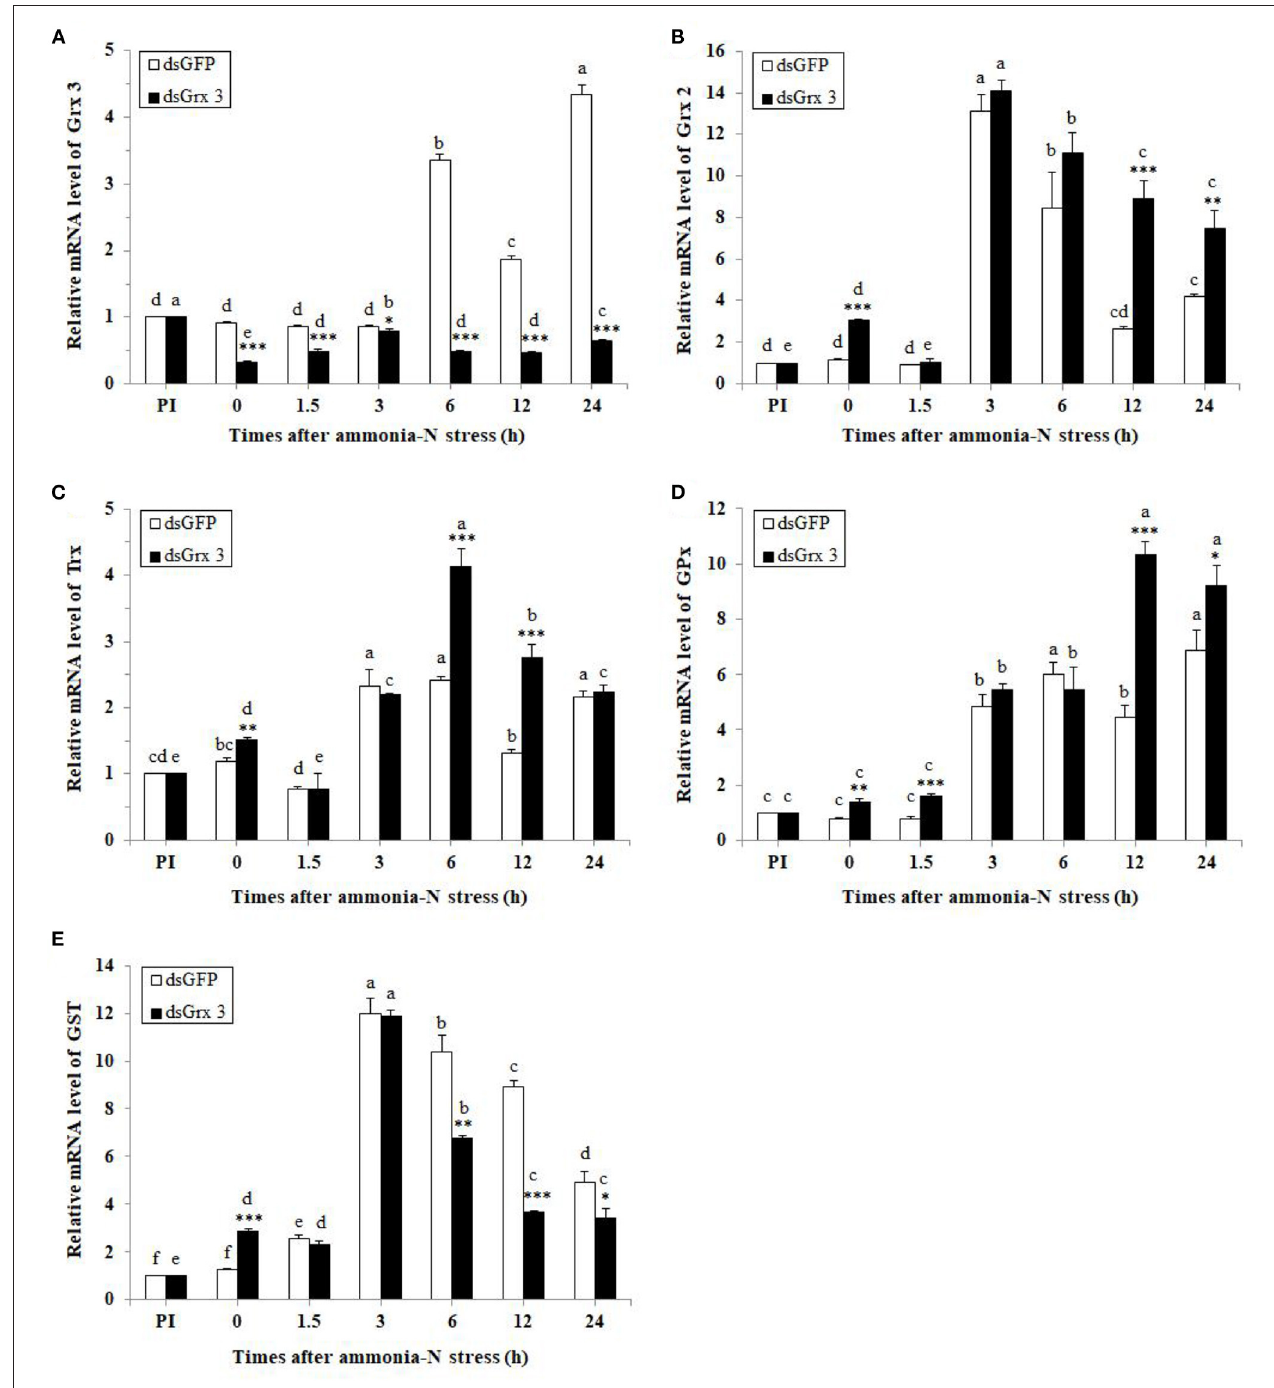
FIGURE 10 | Expression profiles of five genes [LvGrx 3 (A) , LvGrx 2 (B) , Trx (C) , GPx (D) , and GST (E) ] in the hepatopancreas of dsGrx 3-injected shrimp were collected after exposure to ammonia-N (dsGFP-injected shrimp was used as the control) ( n = 9). PI, pre-injection of dsRNA. Significant differences between dsGrx 3 and dsGFP-injected shrimps at the same exposure time are indicated with asterisks (* P < 0.05; ** P < 0.01; *** P < 0.001). The calculated data in the same group with different letters are significantly different ( P < 0.05).